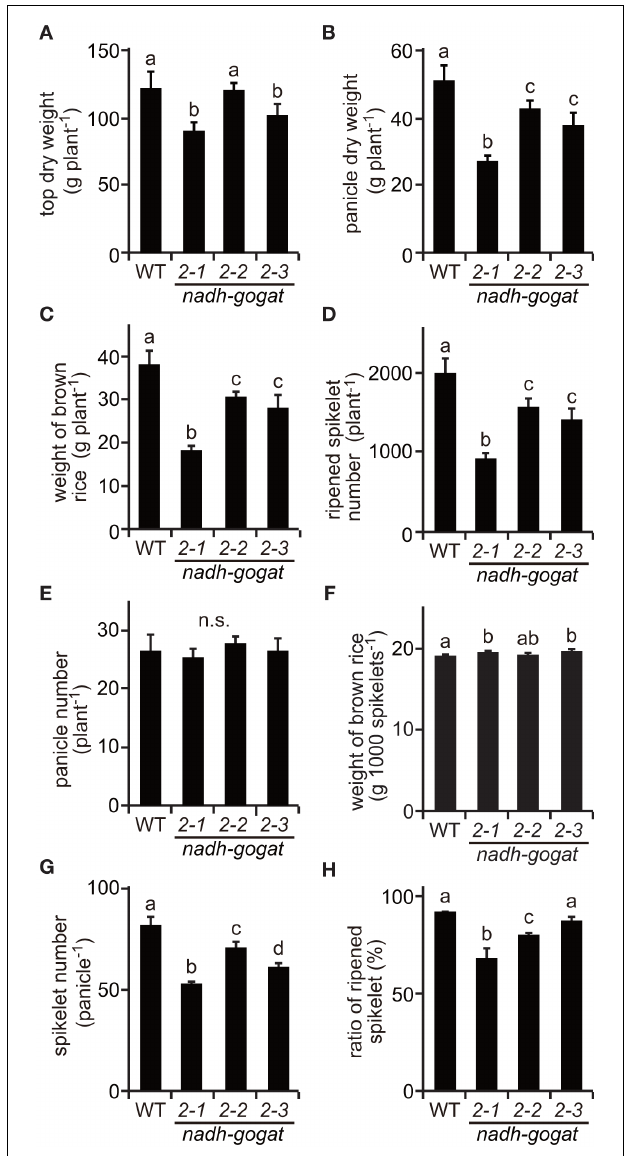
FIGUREA1 | Phenotypic characterization of the mutants at ripening stage cultivated in 2009. (A) Total dry weight of top part (above ground) per plant. (B) Total dry weight of panicles per plant. (C) Total weight of brown rice per plant. Names of three mutant lines were the same as described in Figure 2 . (D) Total ripened spikelet number per plant. (E) Total panicle number per plant. (F) 1,000 brown rice weight. (G) Spikelet number per panicle. (H) Proportion of well ripened grains. Means of three independent samples and SD are indicated. Significant differences in these three lines by one-way ANOVA are indicated by lower-case letters (a, ab, b and c). No significant difference is indicated as in n.s. Different letters indicate significant differences ( P < 0.05) in Holm–Sidak corrected post hoc tests following an ANOVA.